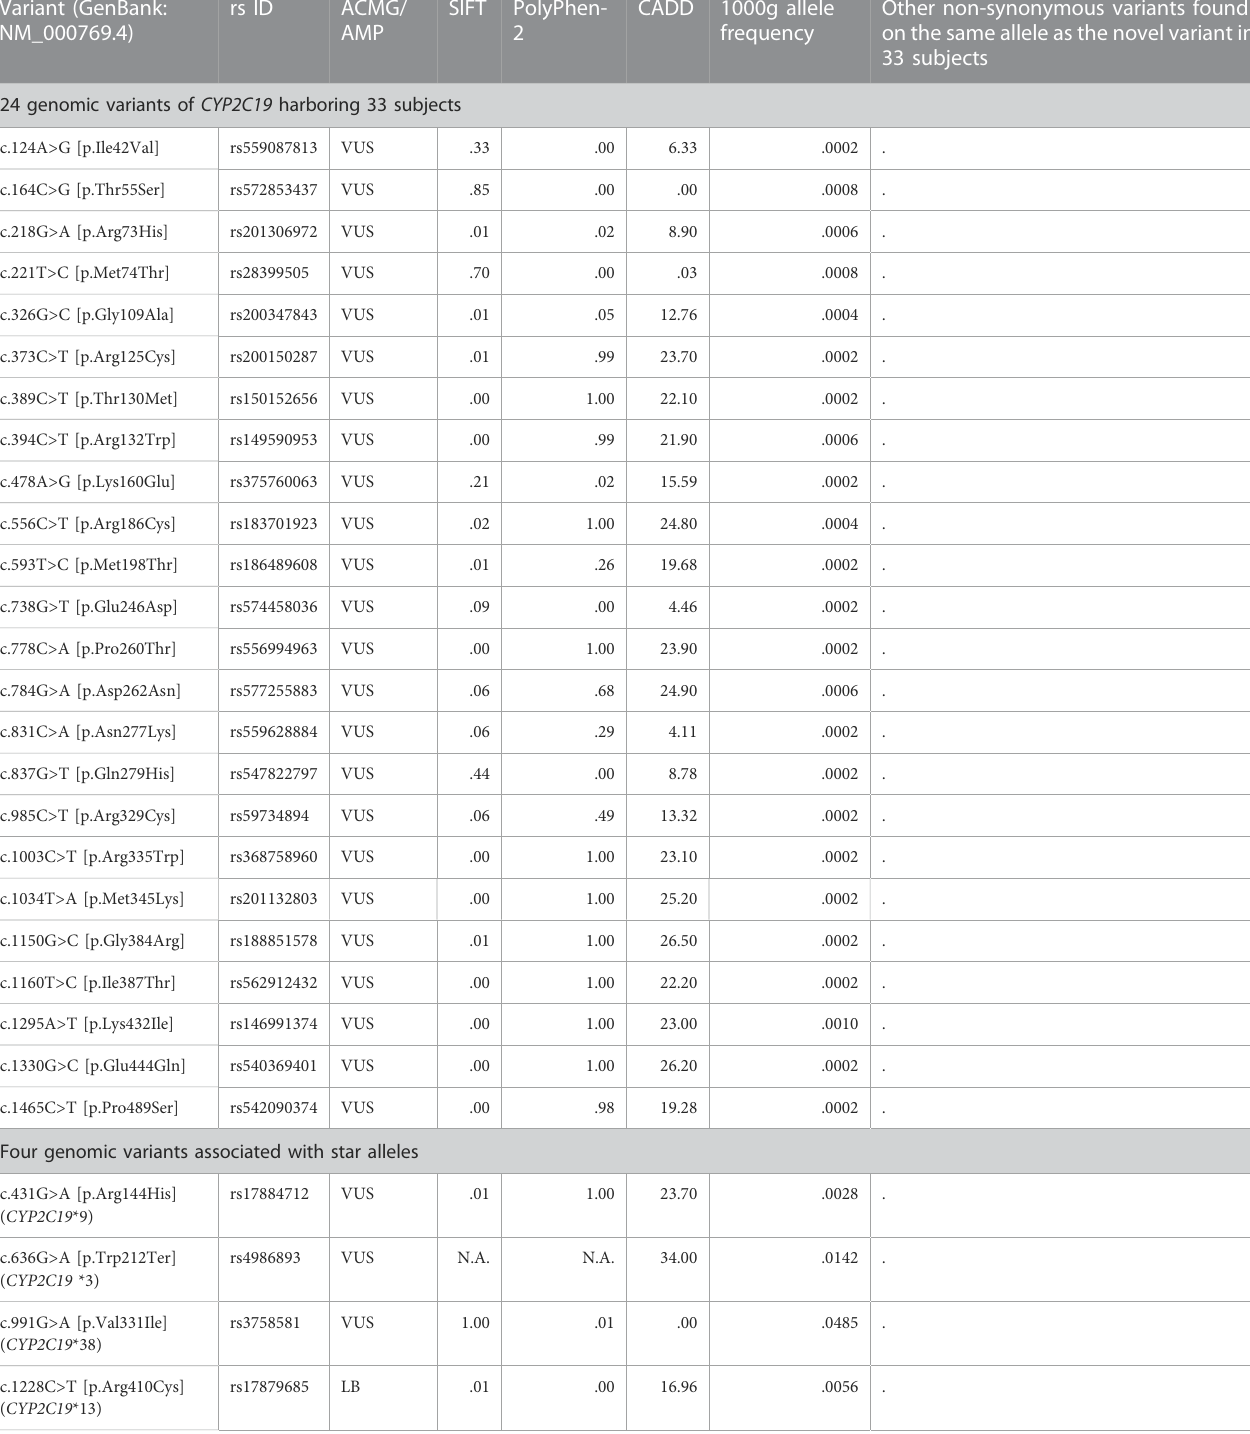
TABLE 2 28 genomic variants of CYP2C19 selected for metabolizing enzyme activity assay. Variant (GenBank: